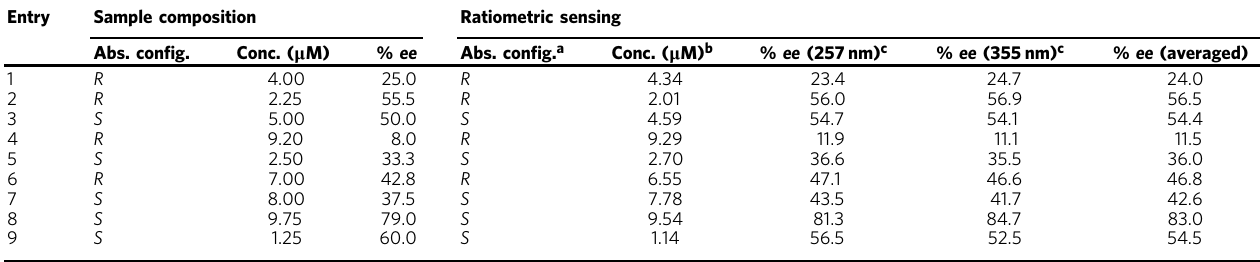
Table 1 UV/CD sensing of samples of 10 with varying concentrations and ee ’ s using 3 Entry Sample composition